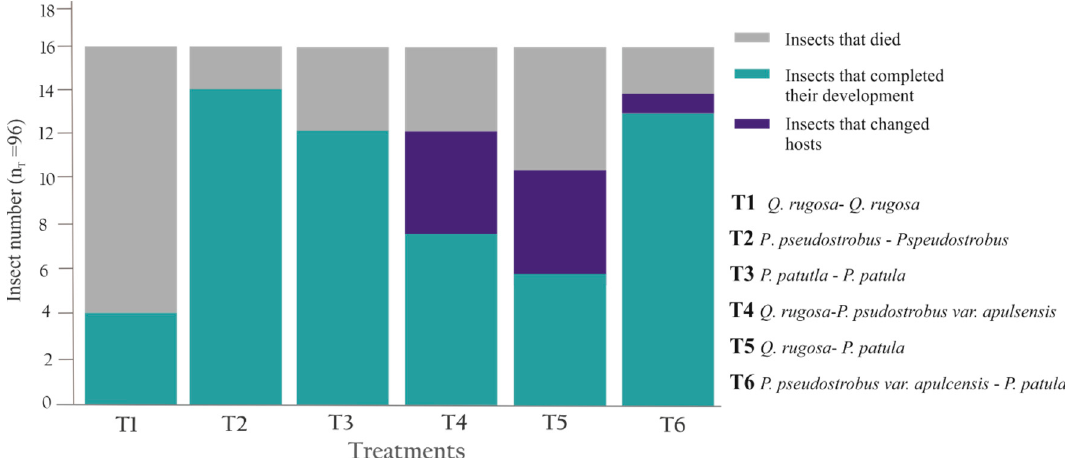
Figure 12. The results of the walking test to paired host tree selection of specimens of Ocoaxo assimilis from nymphal stages NIV. Homospecific (T1–T3) and heterospecific treatments (T4–T6).